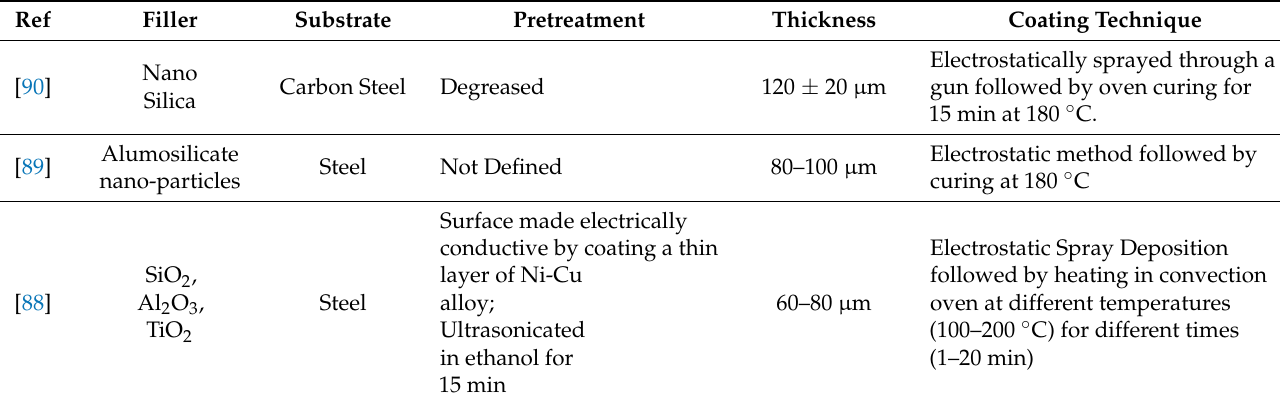
Table 8. Different types of coating techniques and pre-treatment techniques used by researchers.